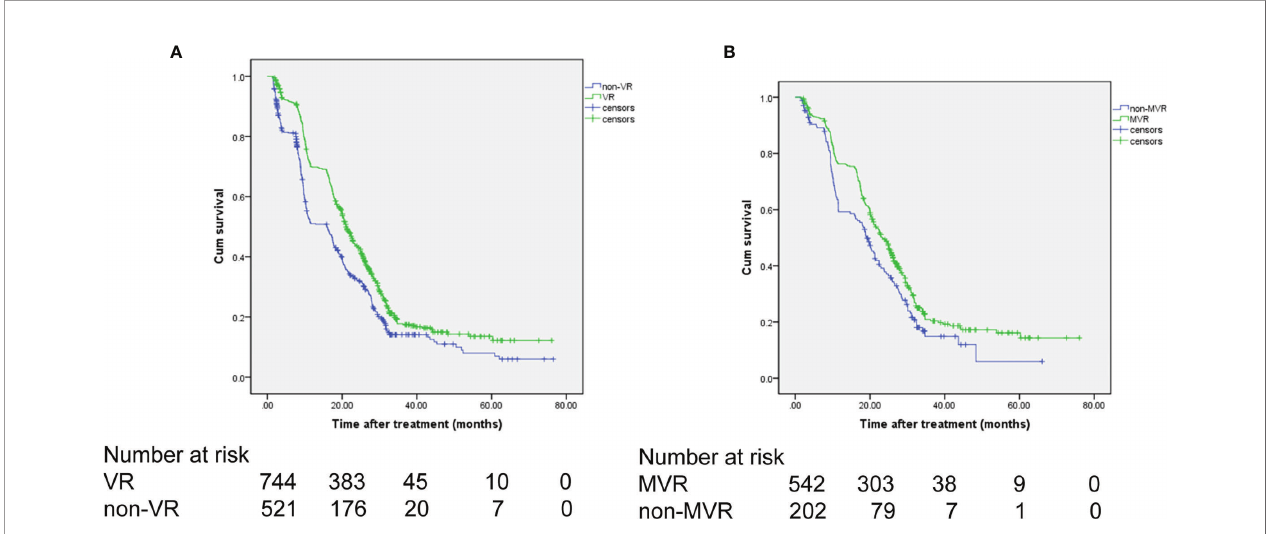
FIGURE 2 | OS of the patients receiving NA therapy. (A) OS comparison between the VR and non-VR groups. (B) OS comparison between the MVR and non-MVR groups. OS, overall survival; NA, nucelos(t)ide